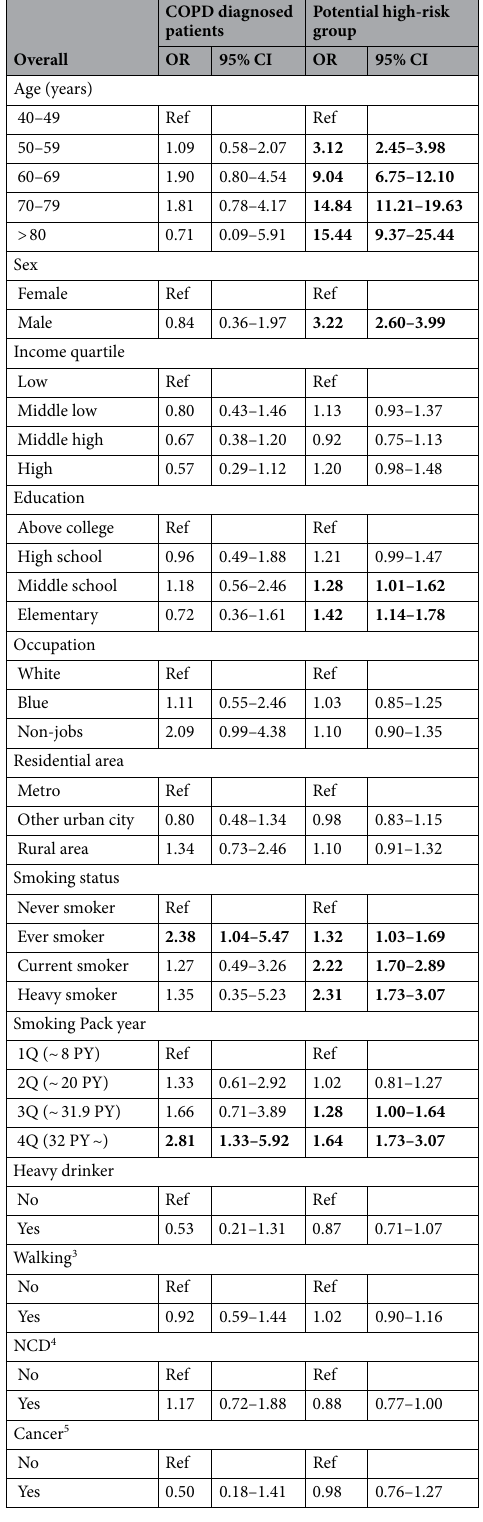
Table 2. Multivariable logistic regression to determine the factors identifying subjects with COPD. Significant values are in [bold]. 1 Unweighted number of respondents. 2 Weighted percentage. 3 Heavy drinker is consuming 5 drinks or more per week for women and 8 or more for men. 4 Walking practice: Person who walked for 30 min at a time over the past week for 5 days. 5 NCD: Non-Communicable Disease (physician diagnosis about hypertension, diabetes mellitus, dyslipidemia, etc.). 6 Cancer: Experience of cancer (stomach, liver, colon, breast, cervix, etc.)